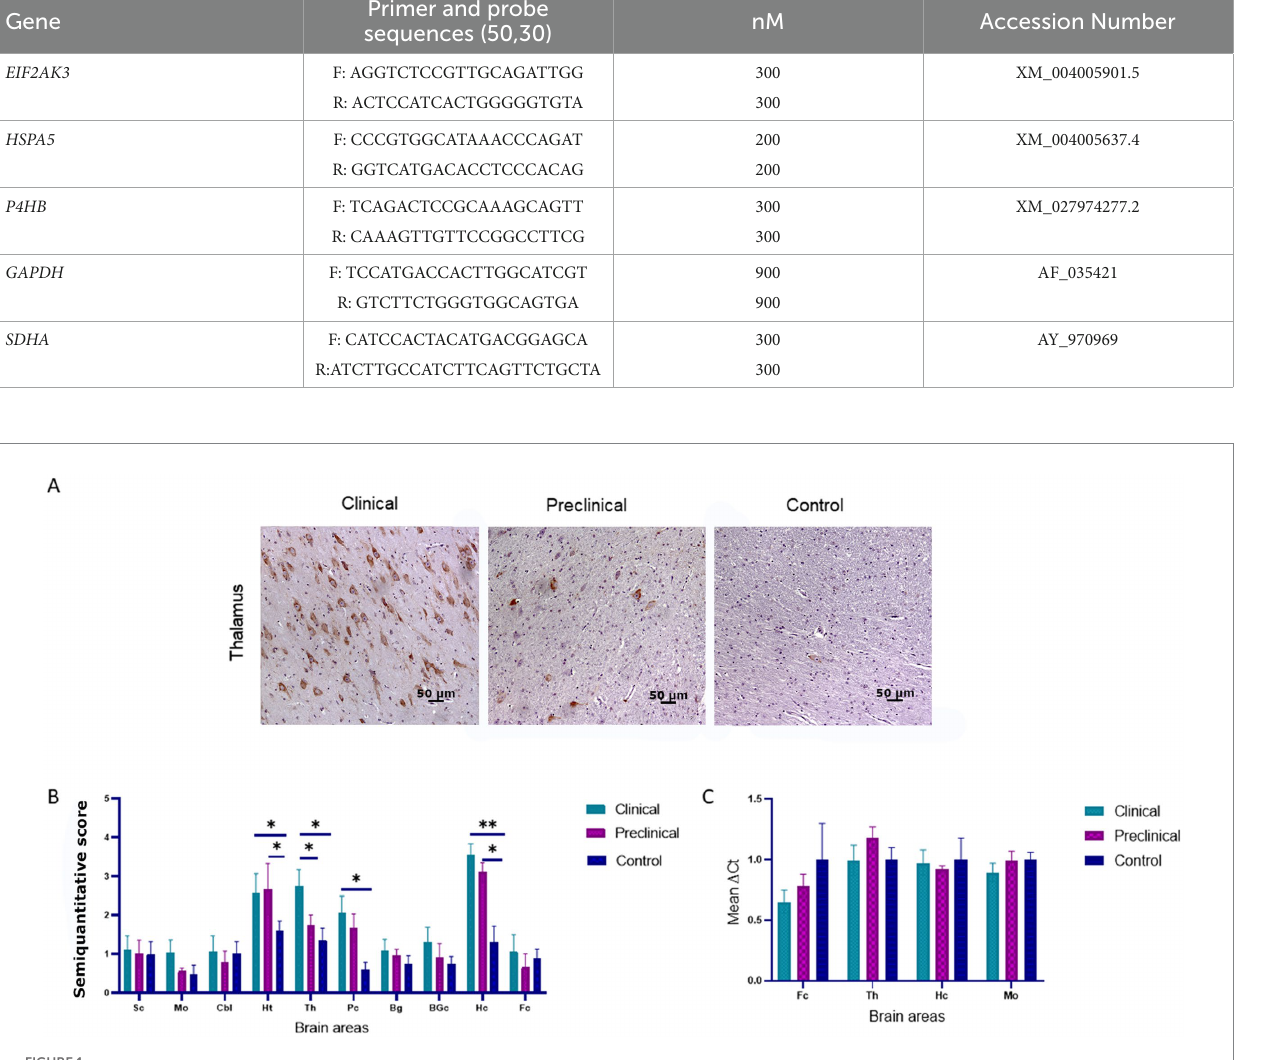
FIGURE 1 PRK-like Endoplasmic Reticulum Kinase (PERK) expression in clinical and preclinical scrapie-infected sheep and healthy sheep. (A) Immunohistochemical detection of PERK in thalamus. PERK-positive immunostaining was detected in cellular nuclei from clinical, preclinical and control sheep. A higher number of immunopositive cells is observed in the clinical group. (B) Expression levels of protein PERK in eight clinical, five